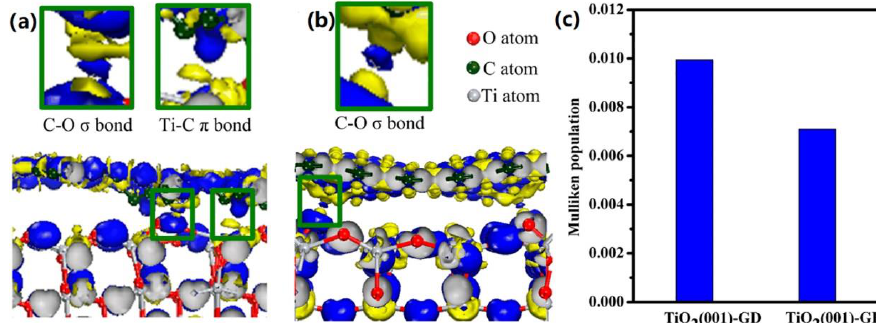
Figure 8. Plots of electron density difference at the composites interfaces: ( a ) TiO 2 (001)-GD; ( b ) TiO 2 (001)-GR; ( c ) Mulliken charge of GD or GR (graphene) surface in the composites. Reprinted with permission from [83]. Copyright 2013, American Chemical Society.